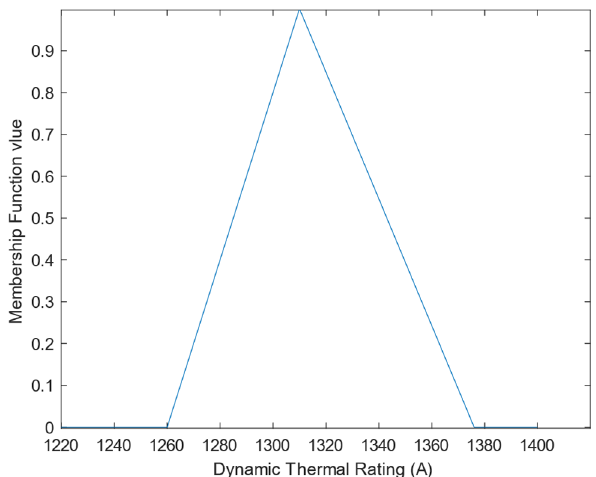
Figure 7. Fuzzy number of dynamic thermal rating.